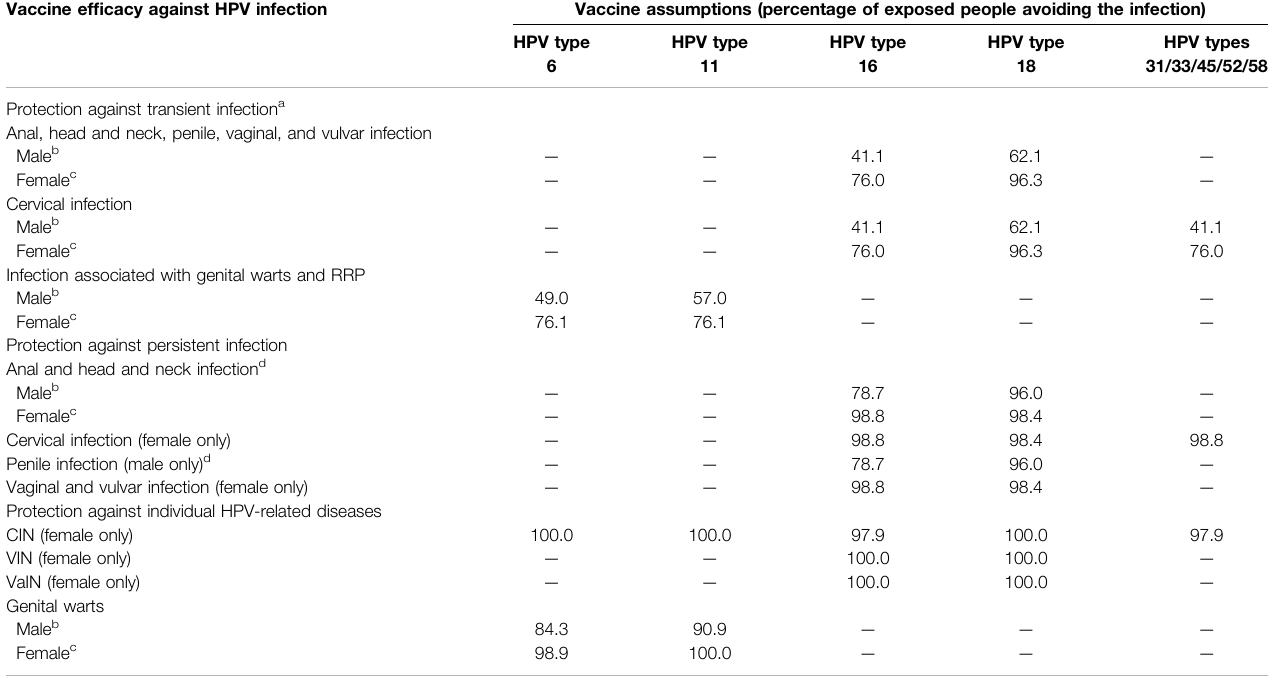
TABLE 2 | Summary table on vaccine characteristics (Joura et al., 2007; Garland et al., 2007; Guiliano et al., 2011; Joura et al., 2015; Palefsky et al., 2011; Ault, 2007). Vaccine ef fi cacy against HPV infection Vaccine assumptions (percentage of exposed people avoiding the